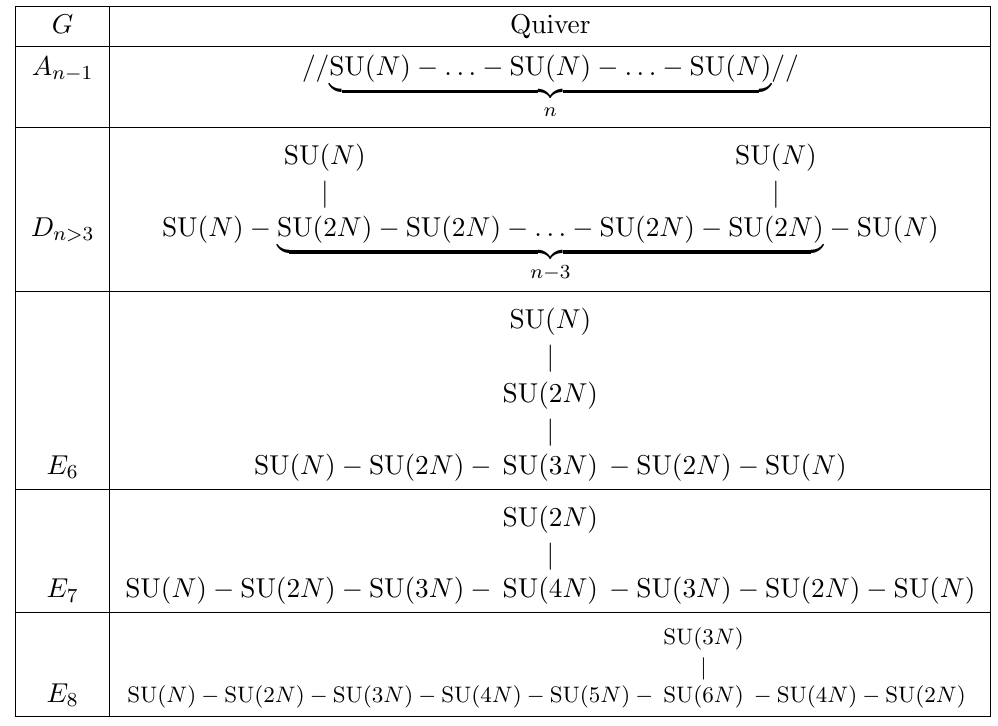
Table 2. The 5d a(cid:14)ne quiver gauge theory descriptions of the KK reductions of the non-minimal conformal matter theories of N M5-branes probing C 2 = (cid:0) G